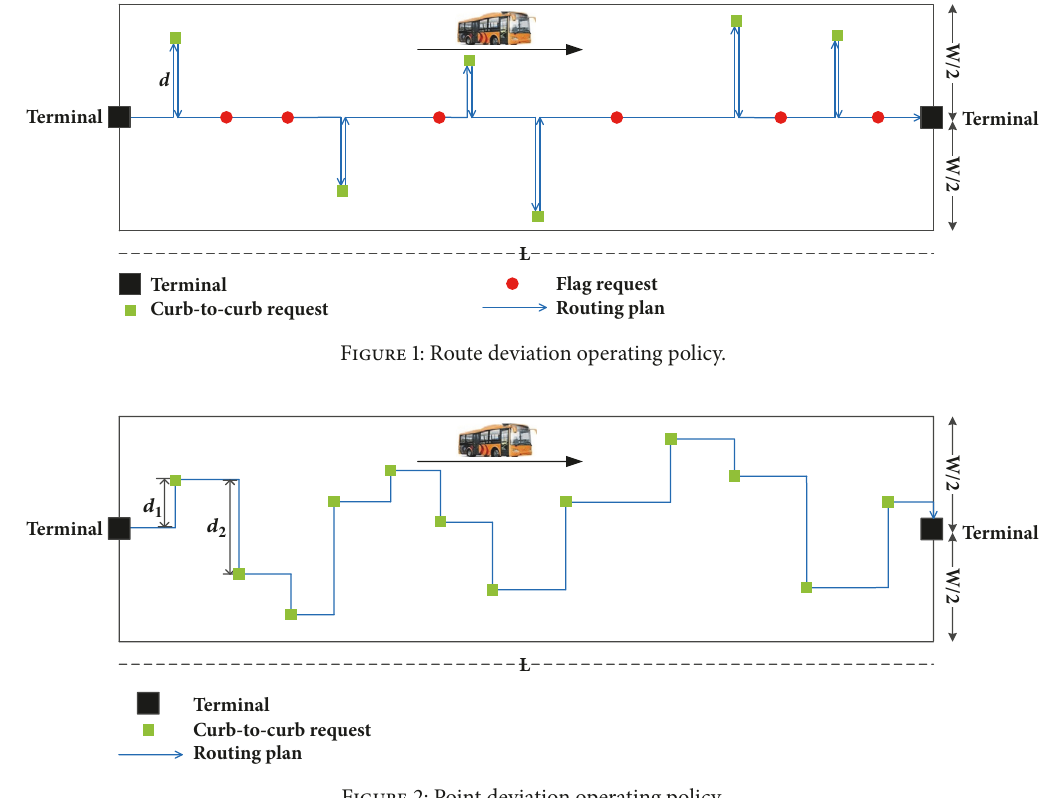
Figure 2: Point deviation operating